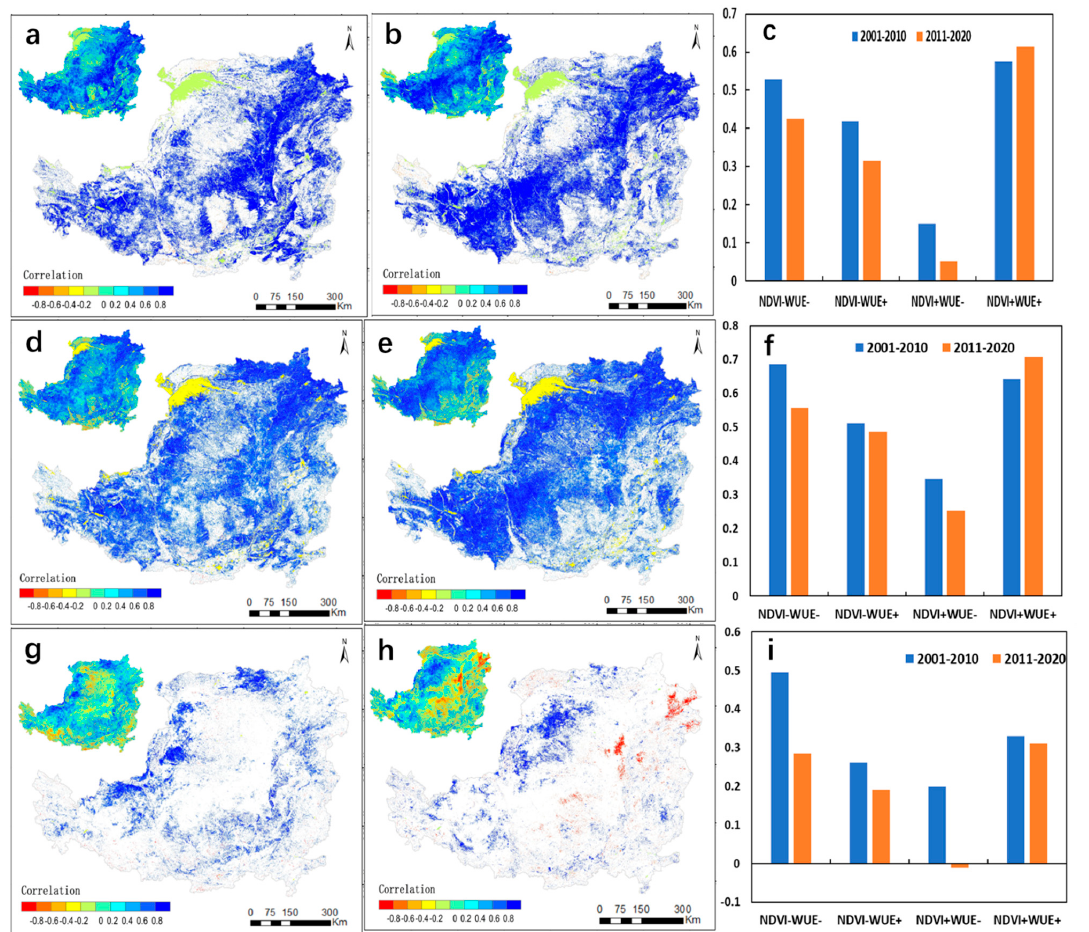
Figure 6. Spatial distribution and statistical images of correlation between NDVI and WUE ( a − c ), NDVI and GPP ( d − f ), and NDVI and ET ( g − i ). ( a , d , g ) are correlations for 2001 − 2010, ( b , e , f ) are cor- NDVI and GPP ( d – f ), and NDVI and ET ( g – i ). ( a , d , g ) are correlations for 2001–2010, ( b , e , f ) relations for 2011 − 2020; the upper right corner is the image without excluding significant p > 0.05 elements ( c , f , i ). Correlation statistics of NDVI with GPP, ET, and WUE.